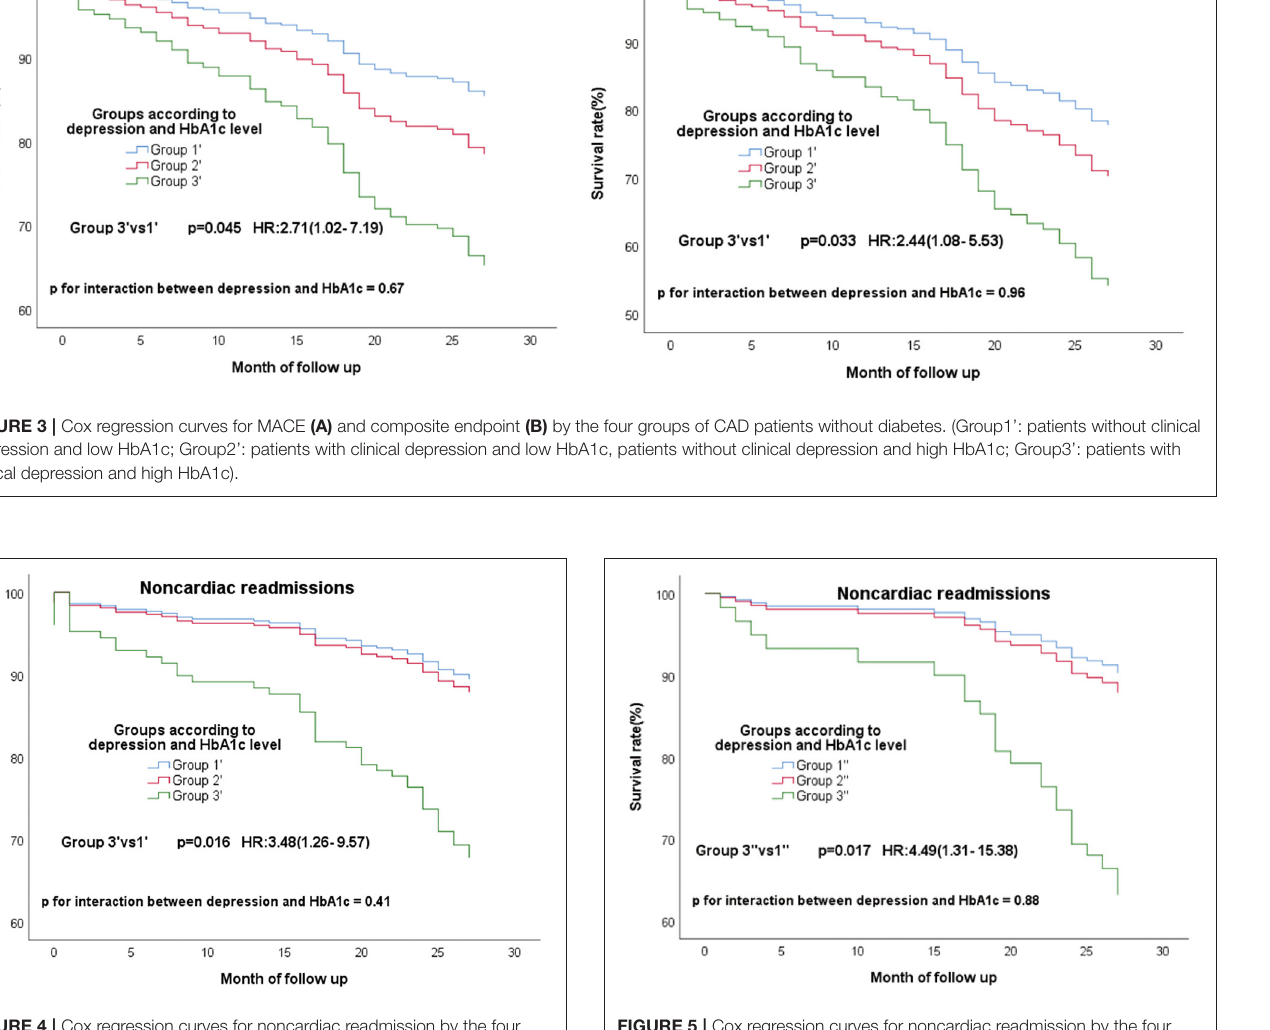
FIGURE 4 | Cox regression curves for noncardiac readmission by the four groups of CAD patients without diabetes. (Group1’: patients without clinical depression and low HbA1c; Group2’: patients with clinical depression and low HbA1c, patients without clinical depression and high HbA1c; Group3’: patients with clinical depression and high HbA1c).